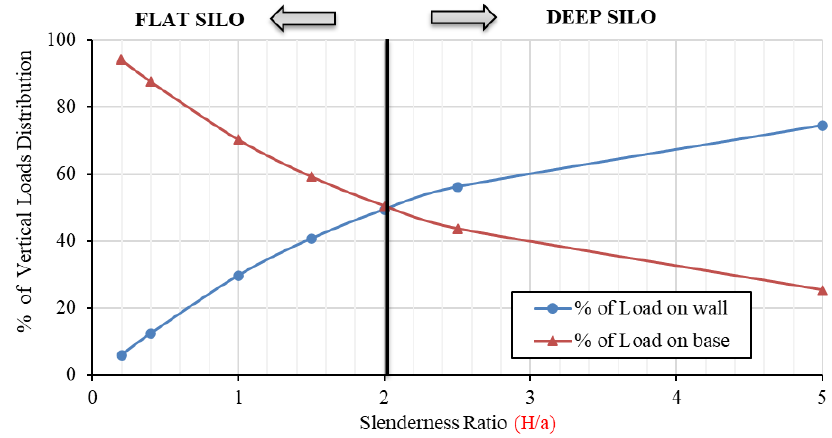
Figure 16. Vertical load distributions inside rigid wall silos for various slenderness ratios.